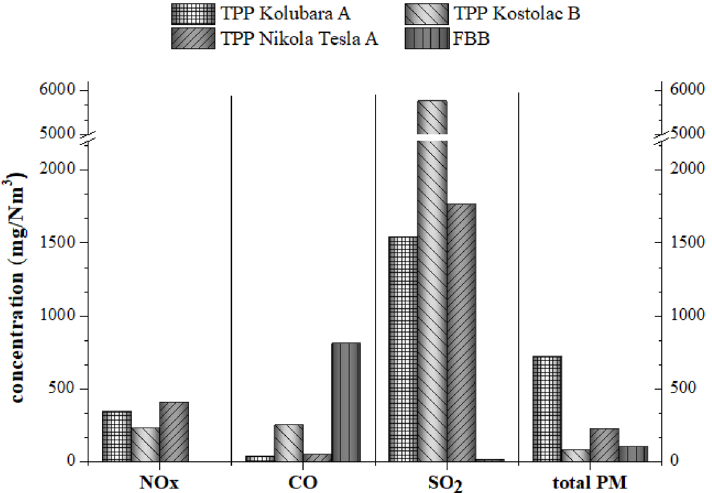
Figure 1. NOx, CO, SO 2 , and total PM concentrations (all in mg/Nm 3 ) in flue gases from TPP K olu- bara A, TPP Kostolac B, TPP Nikola Tesla A , and